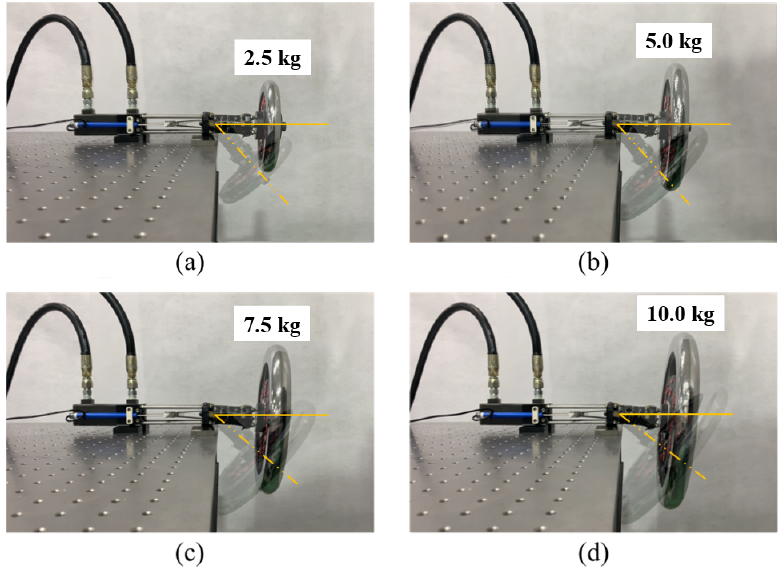
Figure 3. The weight lifting and supporting capability of the SJLM (the transparent areas represent initial positions and the opaque areas are final positions): ( a ) 2.5 kg weight, ( b ) 5.0 kg weight,